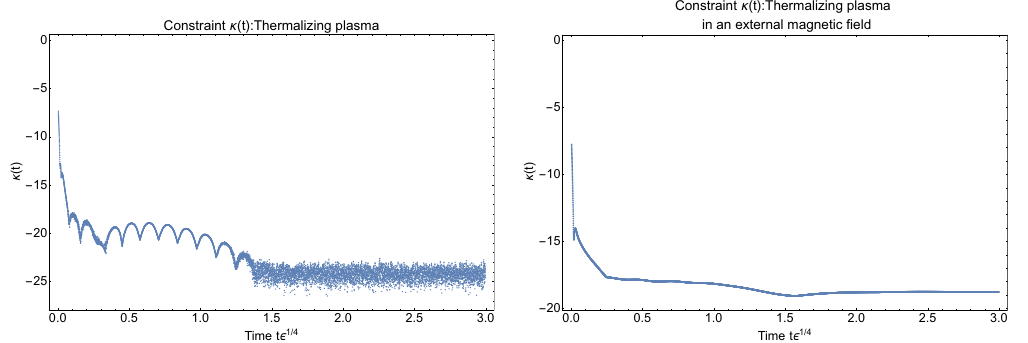
Figure 23 . Constraint violation measured by (cid:20) ( t ) for a constant initial anisotropy B s = 8 (cid:26) = 0 ; B = 0. Right: (cid:26) = 0 ; B = 1.